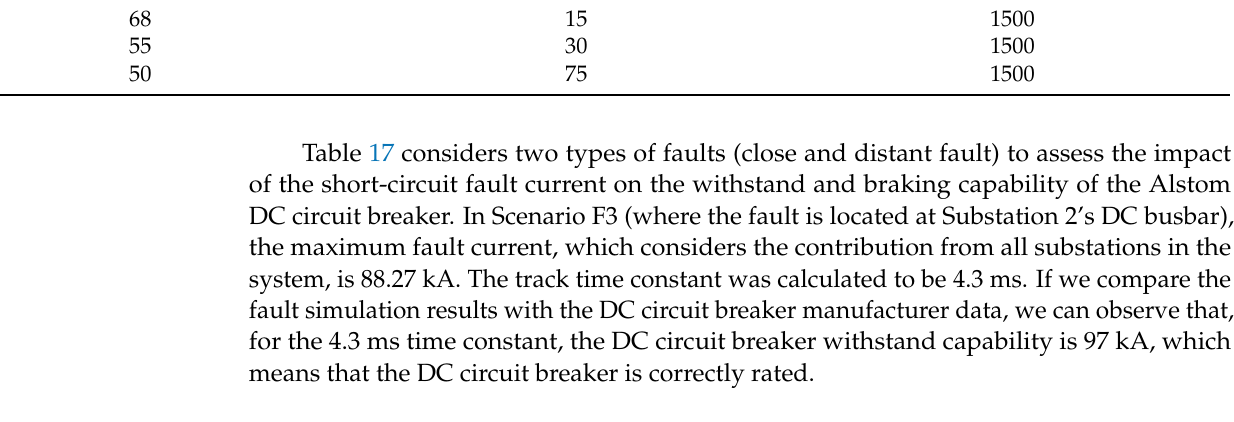
Table 17. DC circuit breaker withstand and breaking capacity